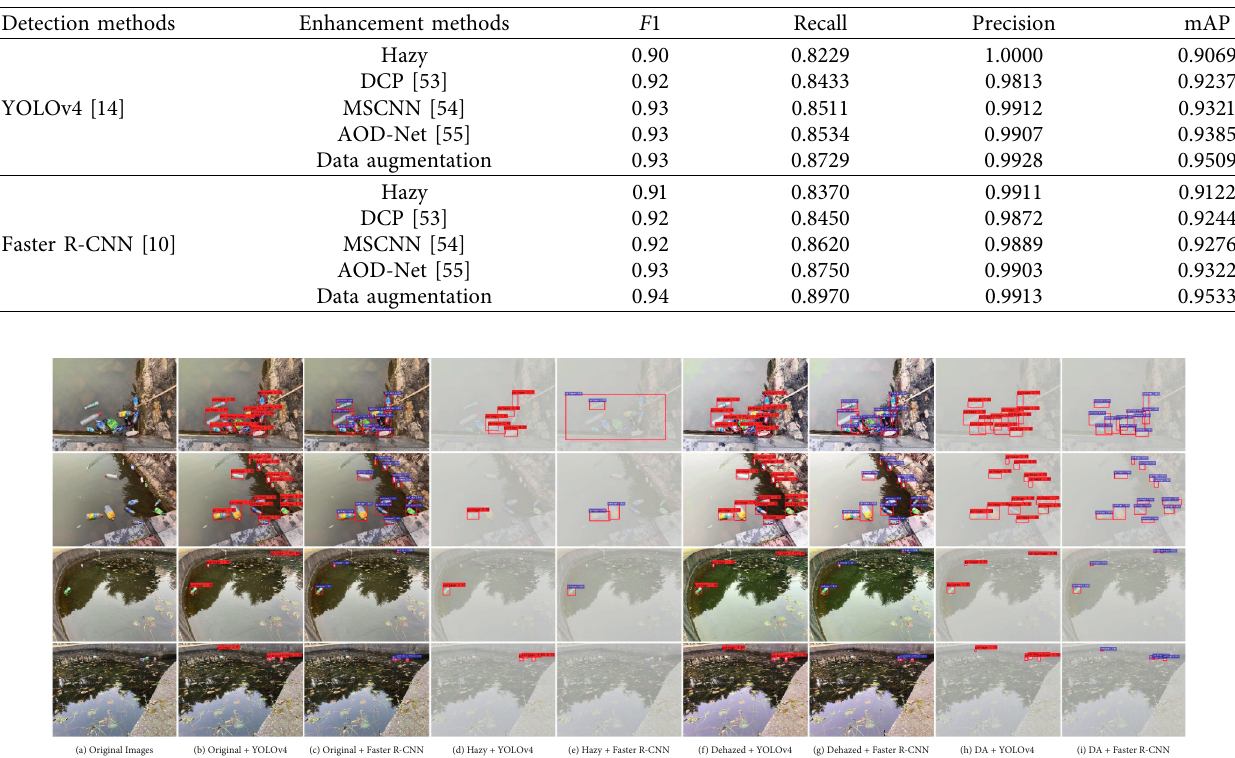
Figure 7: The water-surface garbage detection results under hazy conditions. From left to right: (a) original sharp images, original dataset- trained YOLOv4, and Faster R-CNN for detection results from (b-c) sharp images, (d-e) synthetic hazy images, (f-g) dehazed images, augmented dataset-trained YOLOv4, and Faster R-CNN for detection results from (h-i) synthetic hazy images, respectively. (a) Original images. (b) Original+YOLOv4. (c) Original+Faster R-CNN. (d) Hazy+YOLOv4. (e) Hazy+Faster R-CNN. (f) Dehazed+ YOLOv4. (g) Dehazed +Faster R-CNN. (h) DA +YOLOv4. (i) DA +Faster